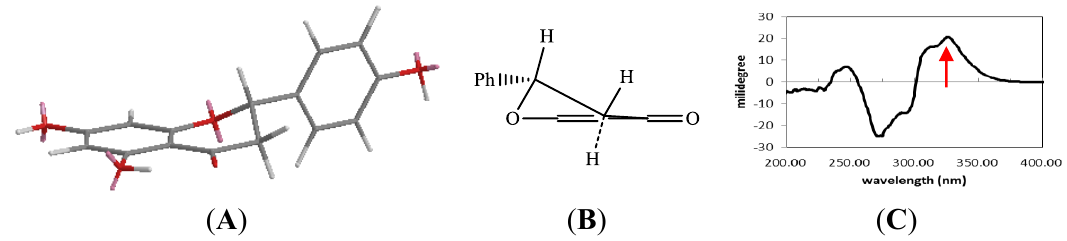
Figure 3. The CD spectrum and the absolute structure of 1 . ( A ): The absolute structure of 1 ; ( B ): The conformation of 1 ; ( C ): CD spectrum of 1 in MeOH (1 mg/mL).